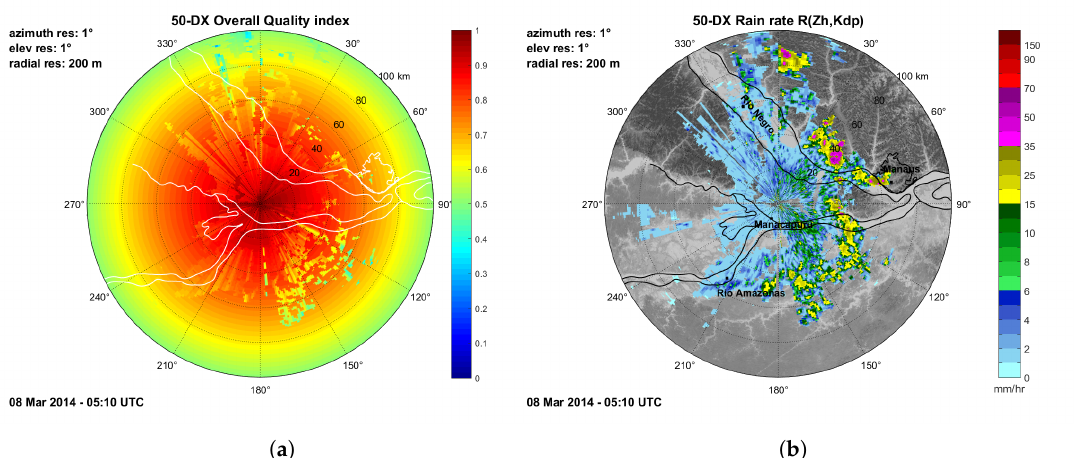
Figure 14. ( a ) Overall radar quality index and ( b ) Rain rate from radar on 8 March 2014 at 05:10 UTC.